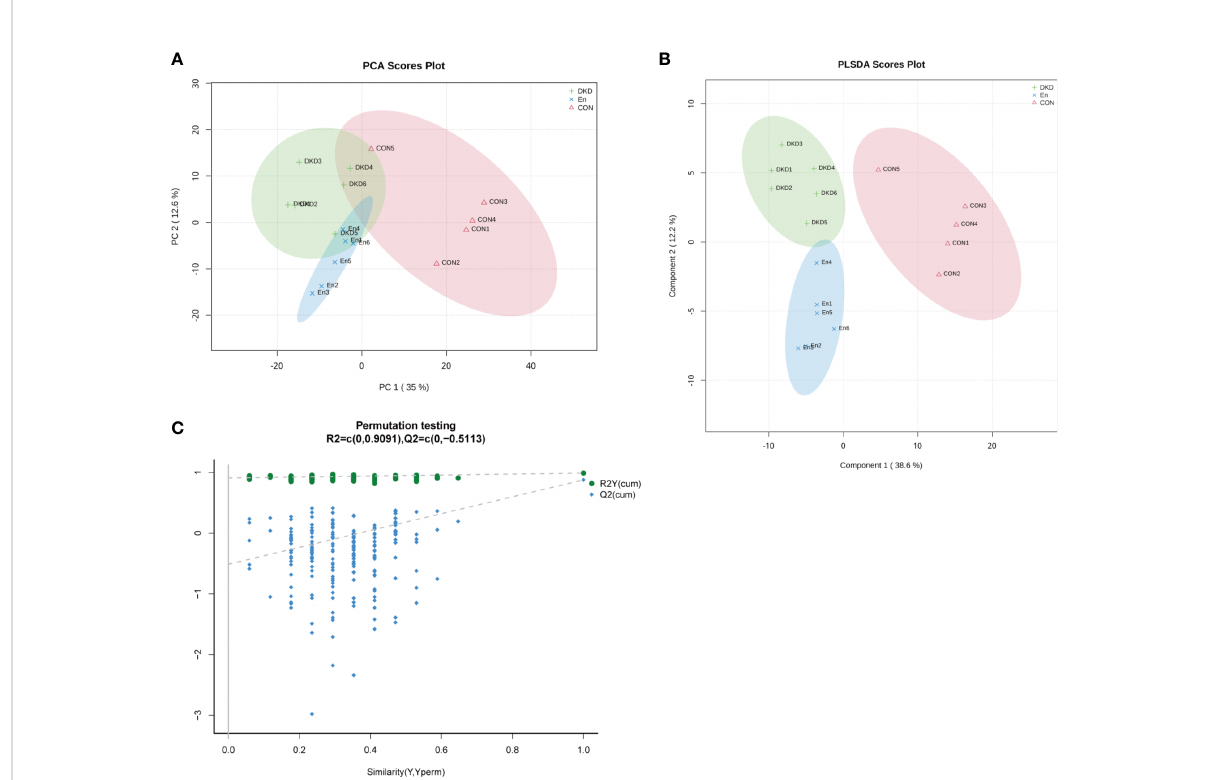
FIGURE 5 Characteristics of metabolic pro fi les in each group. (A) PCA scores plot. (B) PLS-DA scores plot. Component 1: explainability of the fi rst principal component; Component 2: explainability of the second principal component. (C) Permutation testing